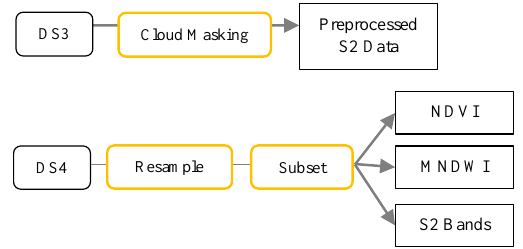
Figure 7. Preprocessing workflow of Sentinel-2 MSI products.